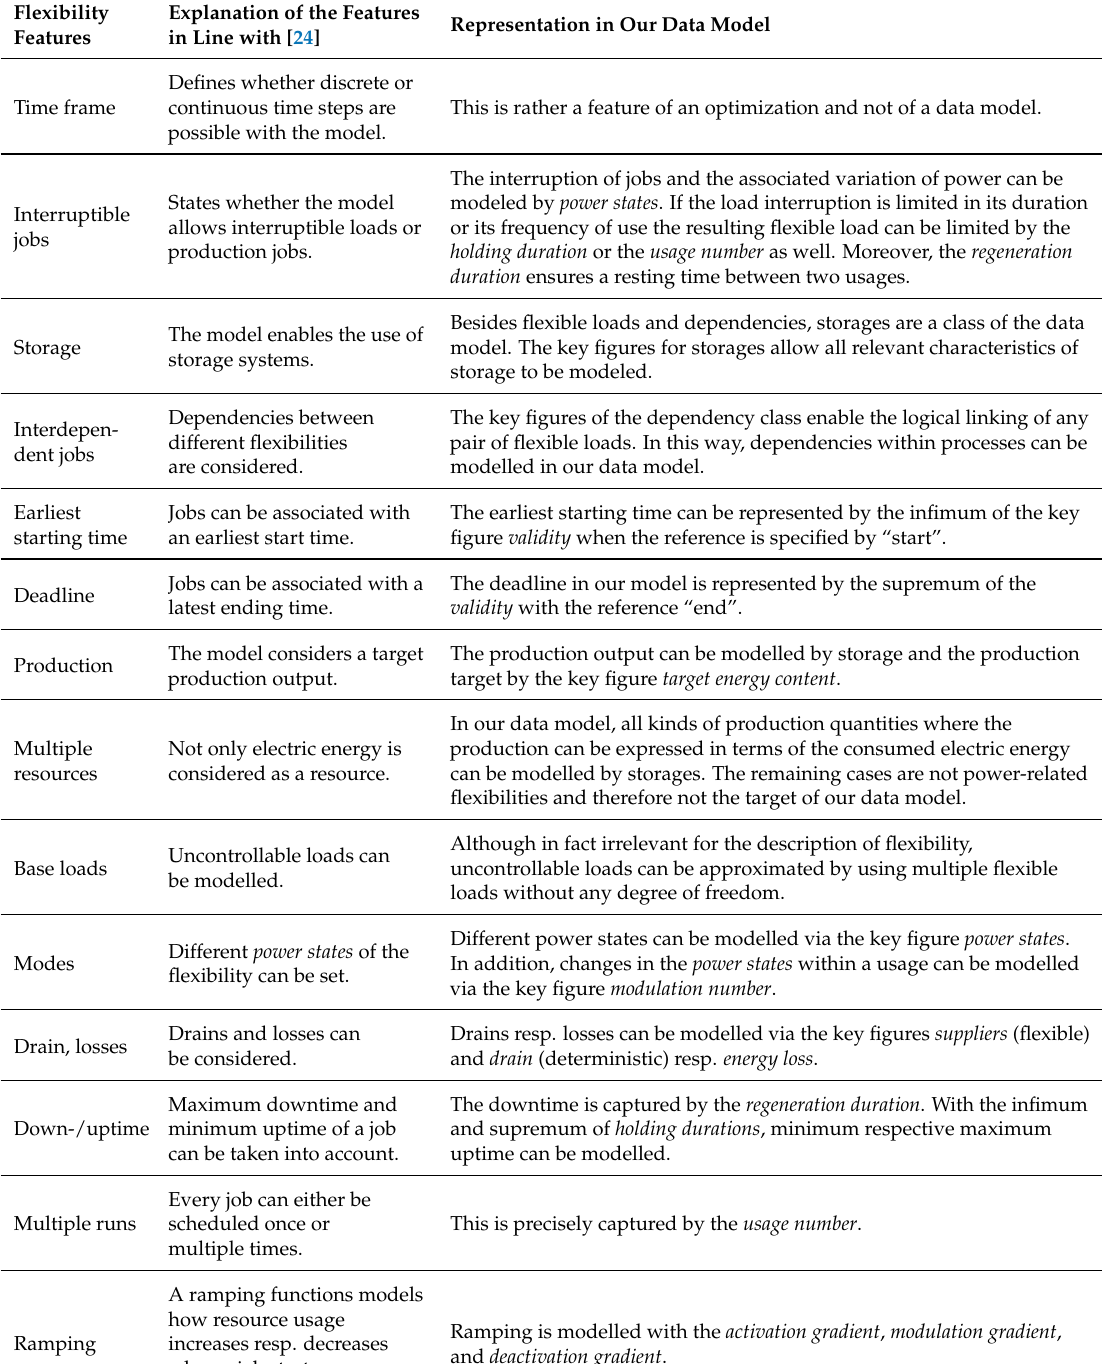
Table 5. Description of the features of Barth et al. [24] and their representation in our data